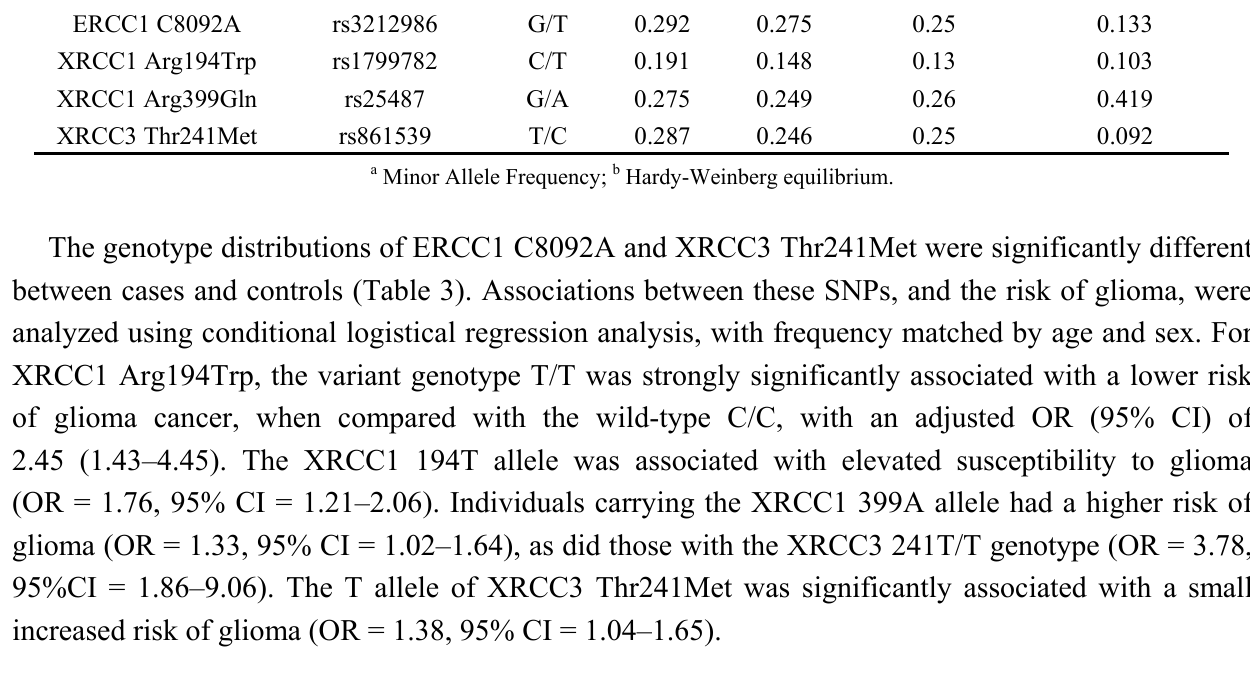
Table 3. Genotype distributions and association with glioma